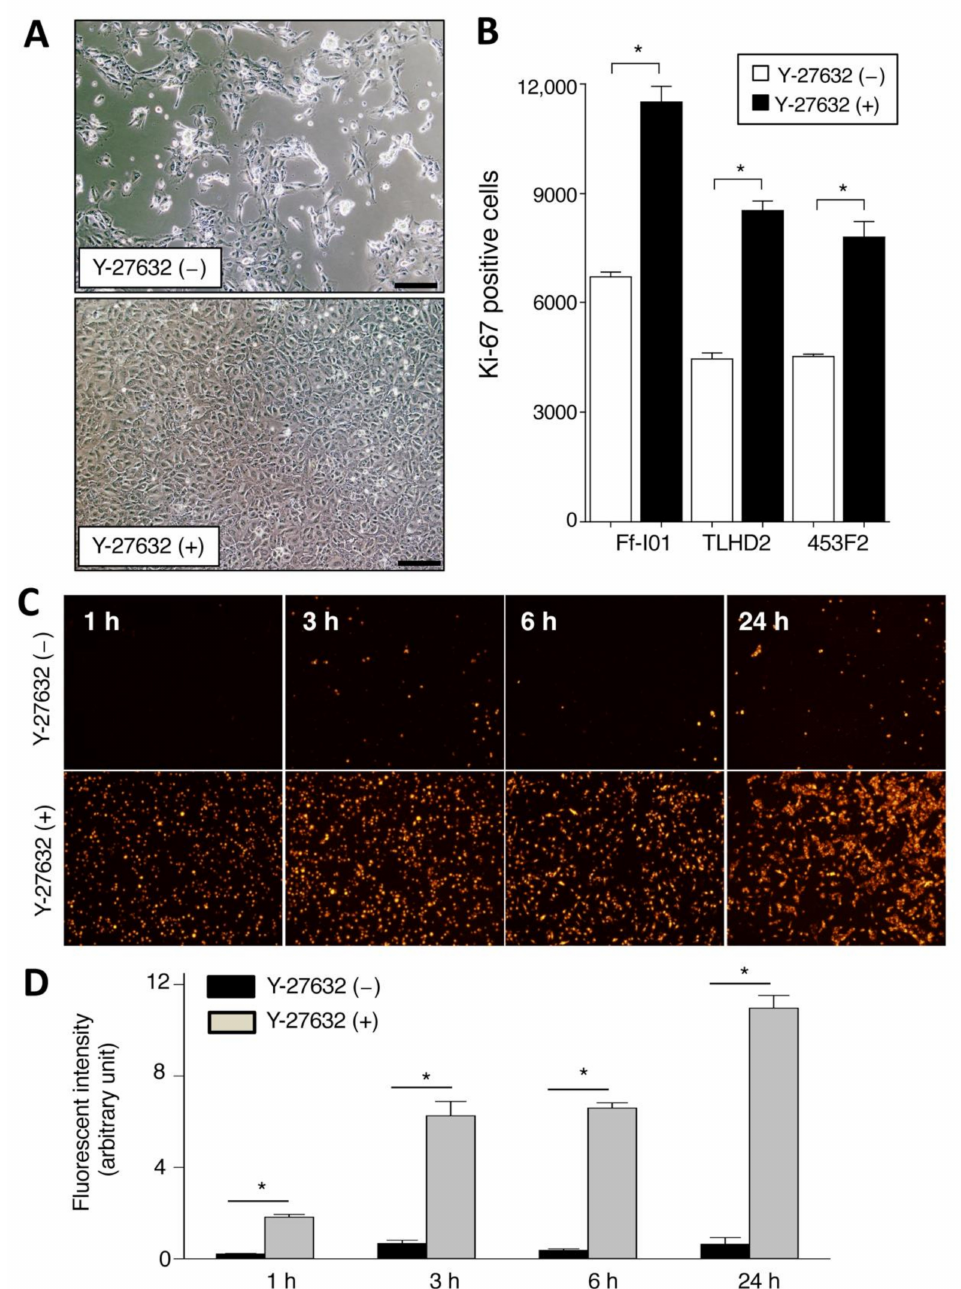
Figure 1. Cell proliferation and adhesion in established human iPS-cell-derived retinal pigment epithelium (RPE) cells that were cocultured with Y-27632. ( A ) RPE cells induced from iPS cells (TLHD2 line) clearly showed polygonal and mostly hexagonal proliferation for 3-day cultures with Y-27632 after reculturing (lower), whereas these iPS-RPE cells without Y-27632 showed poor proliferation (upper). Scale bar = 100 µ m. ( B ) Proliferation of iPS-RPE cells such as lines Ff-I01, TLHD2, and 453F2 showed a similar pattern; proliferation of Y-27632-treated RPE cells was significantly higher than that of nontreated cells by Ki-67-positive FACS analysis. * p <0.05 between two groups. ( C ) Effects of Y-27632 to cell adhesion were examined. Representative cell images were presented. The iPS-RPE cells were labeled with PKH fluorescent dyes and seeded on the 24-well plates without coating materials (1.0 × 10 6 cells/well) in the presence or absence of 10 µ M Y-27632. These cells were incubated at 37 ◦ C for indicated time periods, washed 3 times with 500 µ L of medium, and fixed with 200 µ L of 4% PFA. ( D ) Fluorescence intensity (arbitrary units) was calculated using the ImageJ (* p <0.05 between two groups., n = 2). Similar results were obtained from independent experiments on different